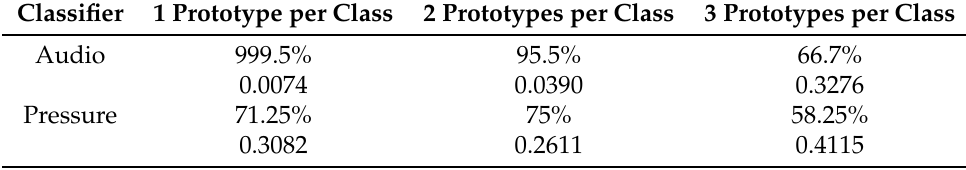
Table 2. Single-input classifiers training using each of the two data sets corresponding to sensors inside the audio/pressure fusion system.